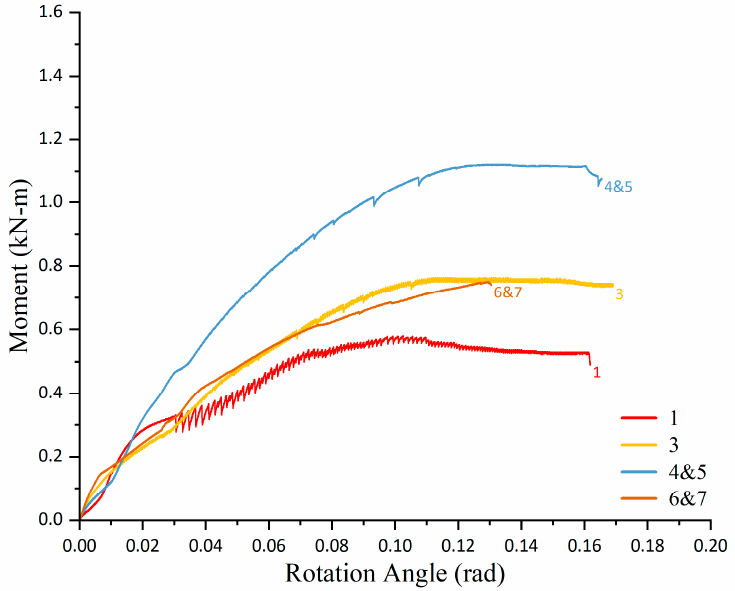
Figure 14. Rotational performance of diverse preventing reinforcement.